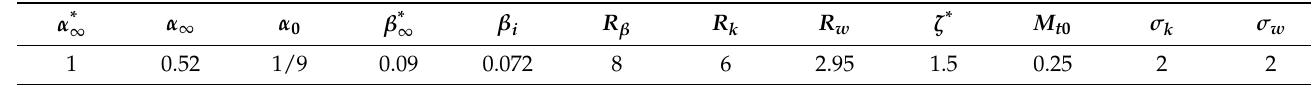
Table 1. Values of the constant used in Equations